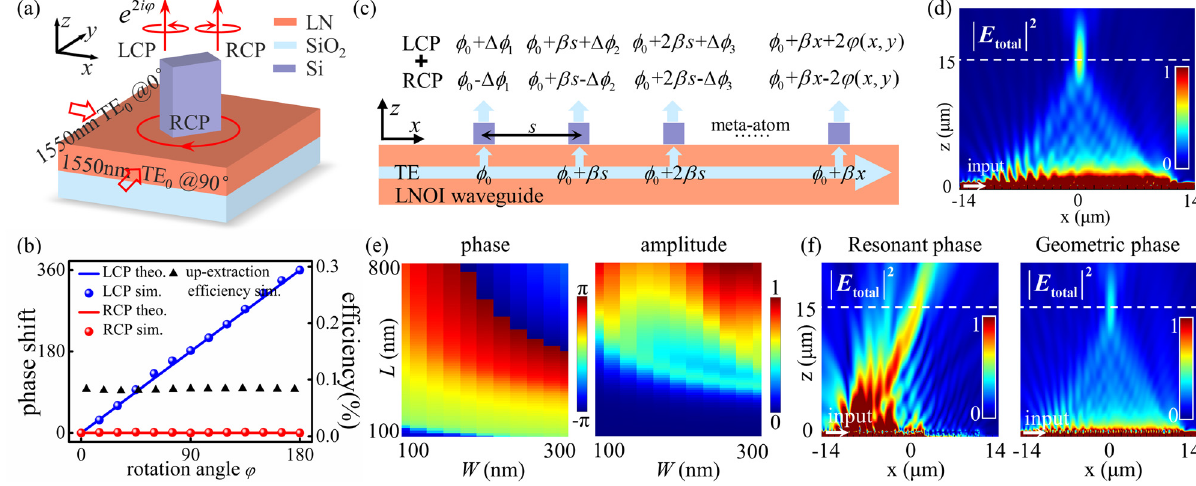
Figure 1: Geometric metasurface interface for guided wave manipulation. (a) Illustration of the Si metasurface integrated on an LNOI waveguide with geometric phase. (b) Numerical simulated phase shifts and up-extraction efficiency as a function of rotation angle φ of meta-atom in (a), driven by guide wave with synthetized RCP. (c) Working principle of geometricmetasurfacesdirectlydrivenbyTEeigenmodeofthewaveguide.ThetravelingTEmodecanbedecomposedintothecombinationofLCP and RCP wave, both of them are coupled out and manipulated by the geometric metasurface with different phase delays. (d) Simulation of a waveguide integrated one-dimensional metalens for off-chip light focusing, indicating the extracted RCP wave is well manipulated. The LN slab waveguidehasheight H =300nm,theSiantennahaslength L =300nm,width W =100nm,andheight H =300nm.Theextractedlightconverged atthedesignedfocalpoint(15 μ mabovethewaveguide)at1550-nmwavelength.(e)Simulatedphaseshiftmapandamplitudemapinaparameter spaceoftheSimeta-atomwidth( W )andlength( L )when H =600nm,thephaseshiftcovers1.995 π rangebutwithverylargeamplitudevariations. (f) Comparison of metasurfaces with resonant phase (chosen from Figure 1(e)) and geometric phase for off-chip light